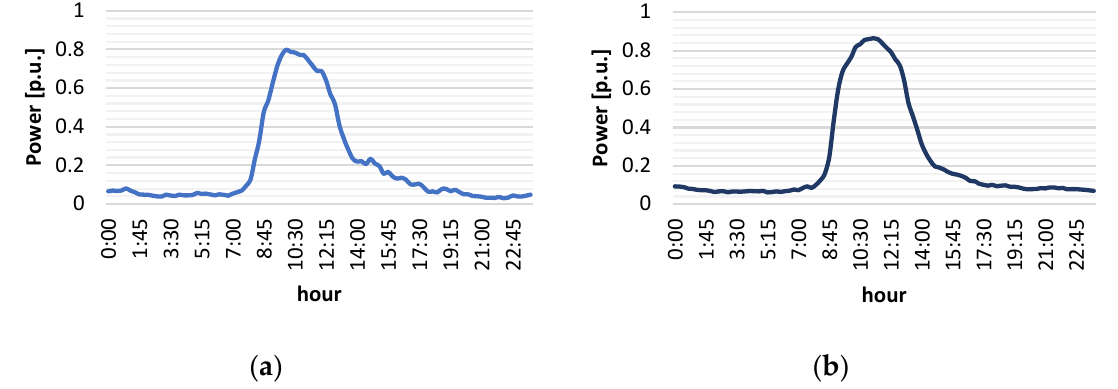
Figure 8. “Residential type profile” obtained in industrial clients I1 (L-S-D) and commercial clients C1 (L-S-D). ( a ) The left curve corresponds to an industrial customer, and ( b ) the right curve corre- sponds to a commercial customer.